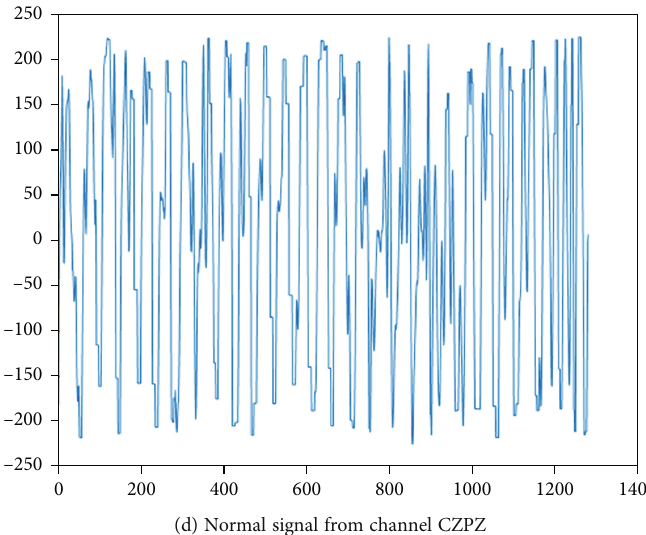
Figure 5: Normal signal and abnormal signal from epileptic